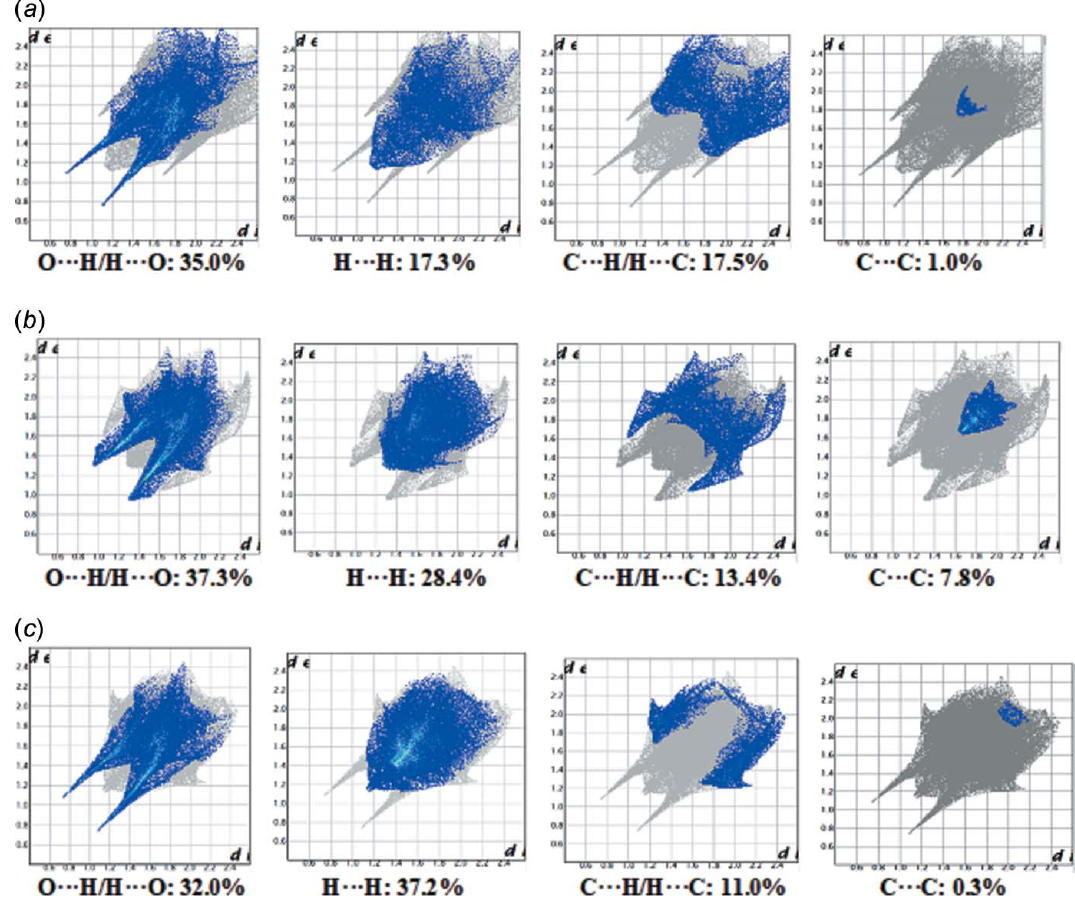
Figure 10 Two-dimensional fingerprint plots showing the contributions of the different types of interactions in ( a ) (I), ( b ) (II) and ( c )